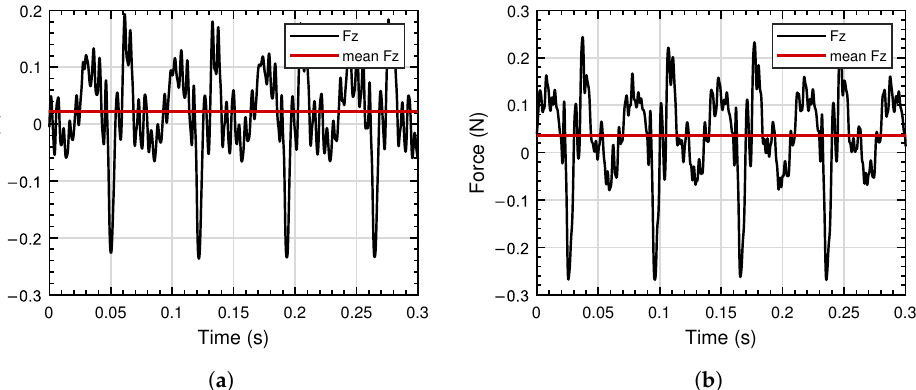
Figure 13. The lift force generated from the flapping wing system at 14 Hz and a 4.5 mm magnet stroke amplitude with a mean lift force of 22.0 mN ( a ) and 14.3 Hz and 4.5 mm magnet stroke amplitude of 5.5 mm with a mean lift force of 35.3 mN ( b